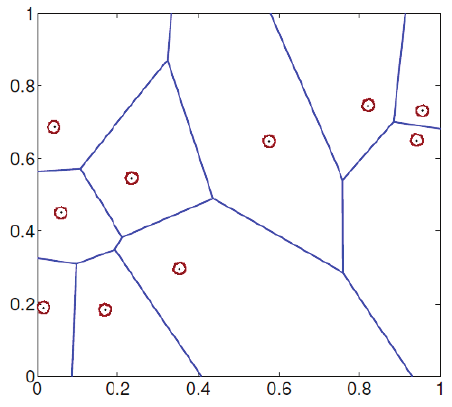
Figure 1. Abstract representation of a simple conceptual space with 2 dimen- sions which is populated by 10 concepts (circled points). Through generation of a Voronoi diagram the boundaries of the concepts can be illustrated. Within CS these boundaries are not explicitly defined or represented, but illustrate the assignment of presented examples as belonging to a single concept through the application of a distance measure (Equations 1 and